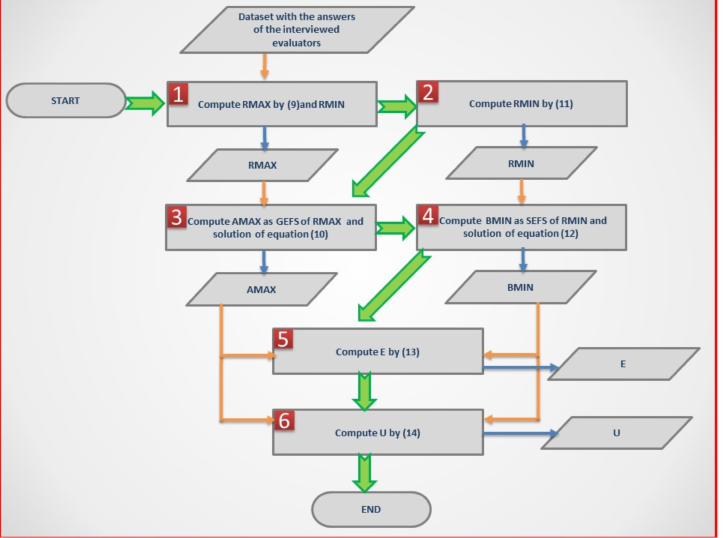
Figure 1. Block diagram schematizing the proposed